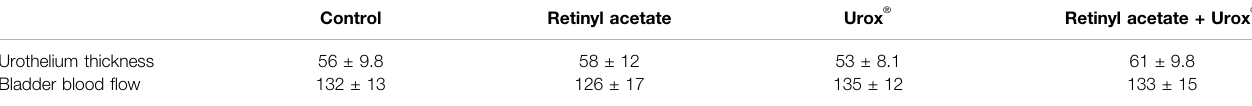
TABLE 2| TheeffectsofUROX ® (840 mg p.o., once daily for 14consecutive days) on retinyl acetate(RA) – induced changes in urothelium thickness and bladder blood fl ow.